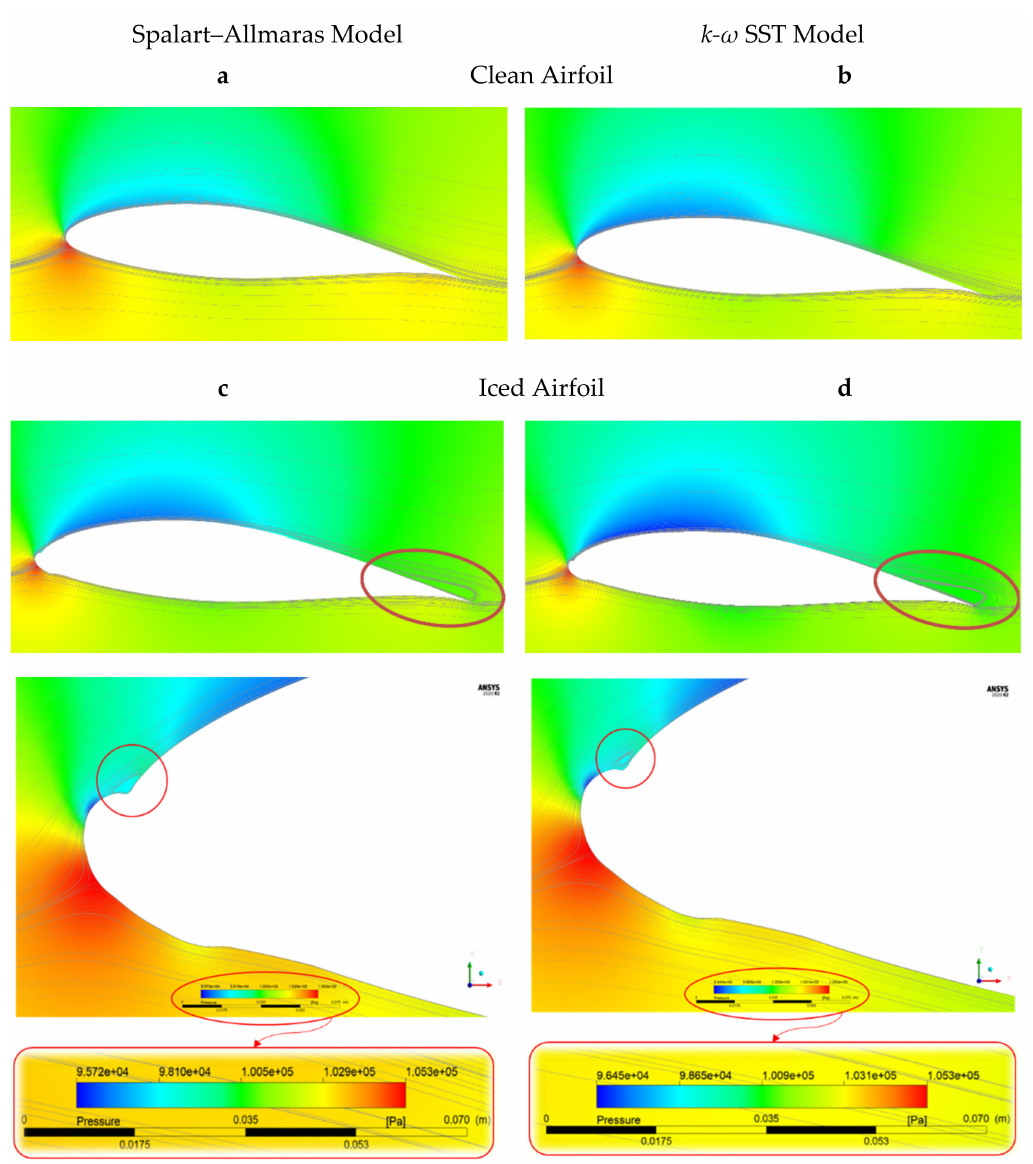
Figure 13. Velocity streamlines with pressure contours resulting from the use of each turbulence model: k- ω SST ( b , d ) against Spalart–Allmaras ( a , c ). The red circles represent recirculation zones at airfoil’s trailing edge and leading